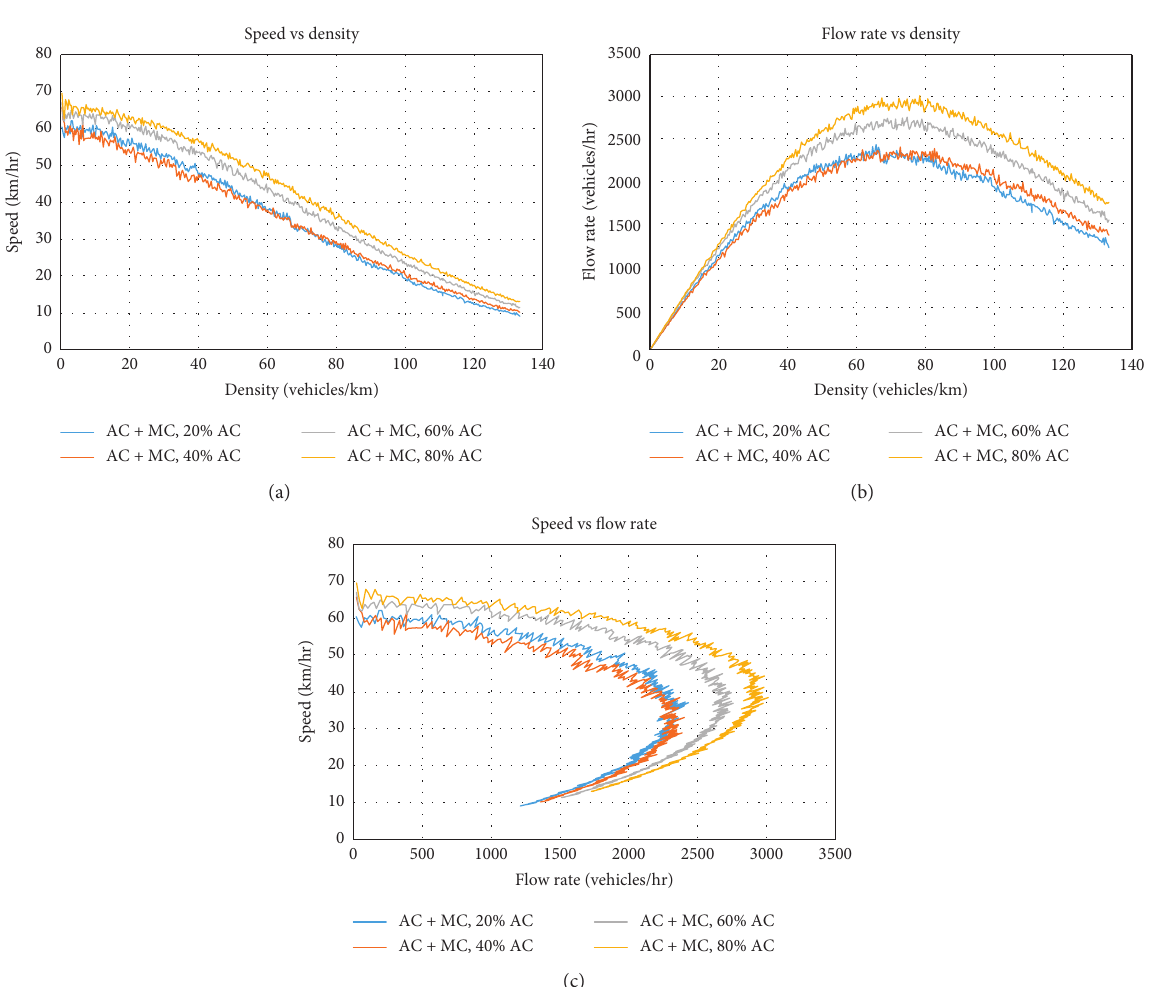
Figure 3: Traffic flow fundamental diagrams for different compositions of AC and